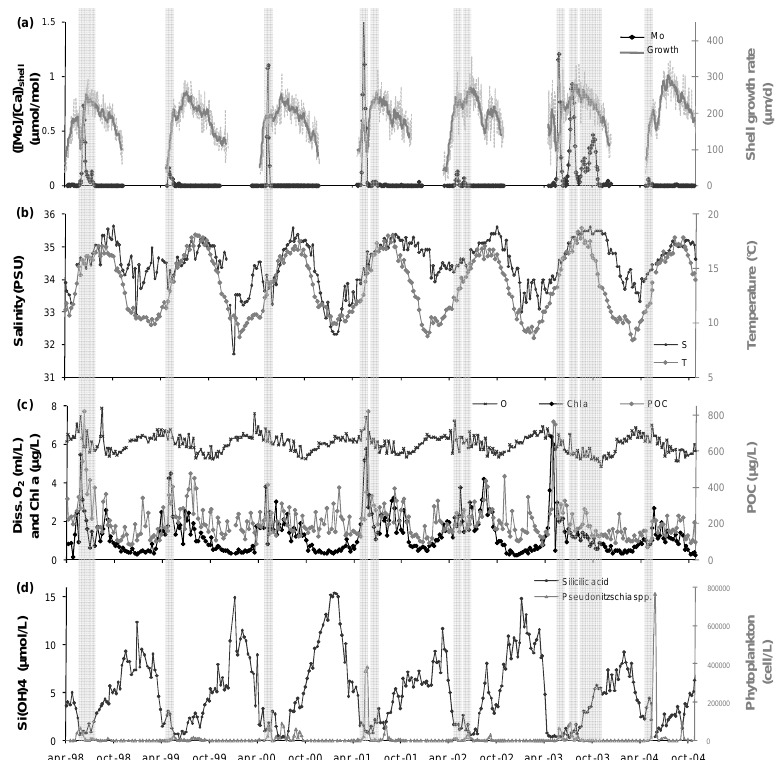
Figure 4. (a) Mean ([Mo]/[Ca]) shell concentration profiles (n=3) from Roscanvel over a 7-year 726 period (1998-2004) compared to shell growth rate (µm/d); (b) salinity (PSU) and temperature 727 (°C); (c) dissolved oxygen (mL/L), chlorophyll a (µg/L) and particulate organic carbon (POC, 728 µg/L); (d) silicic acid concentrations (µmol/L) and Pseudonitzschia spp. concentrations 729 (cell/L) in surface seawater. Environmental monitoring data (weekly resolution) are from 730 SOMLIT station (48°21N, 4°33W), except in 2003 and 2004 for diatom levels (Lanvéoc 731 station (48°18N, 4°27W); 15-days resolution), both stations being in the Bay of Brest near the 732 Roscanvel sampling zone. 733